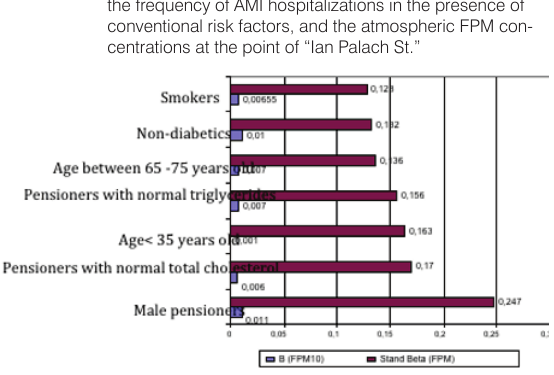
Figure 2. Regression coefficients of the linear correlation between the frequency of AMI hospitalizations in the presence of conventional risk factors, and the atmospheric FPM con- centrations at the point of “Ian Palach St.”